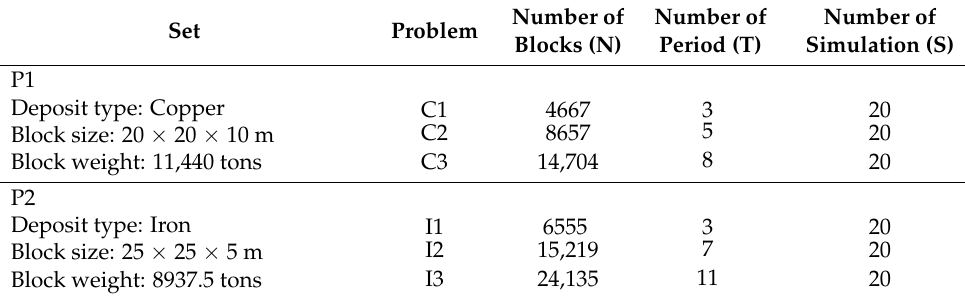
Table 1. Set of problems for the validation of our proposed